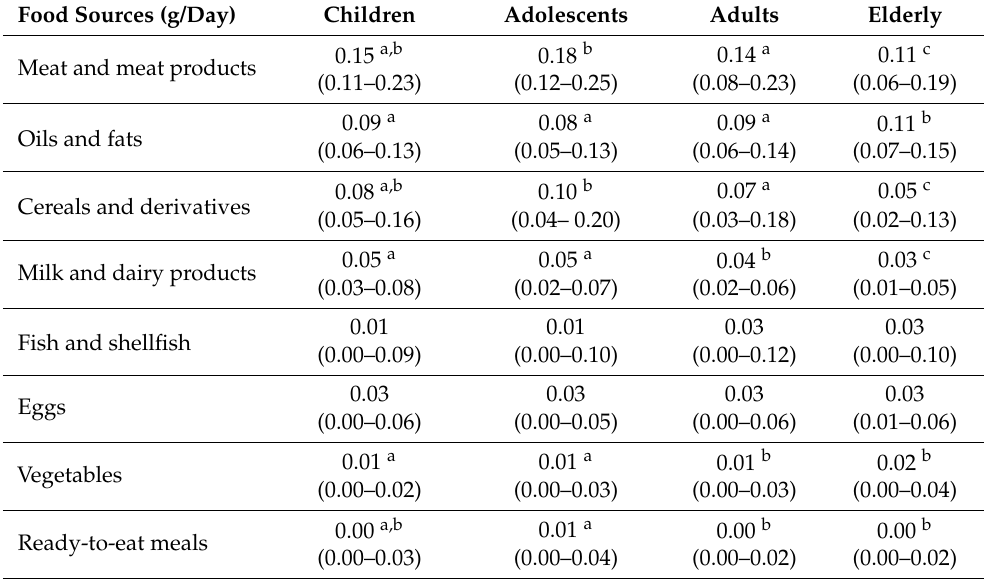
Table 14. Contribution of dietary food sources to α -linolenic acid (ALA) intakes per age group among the ANIBES Study population.